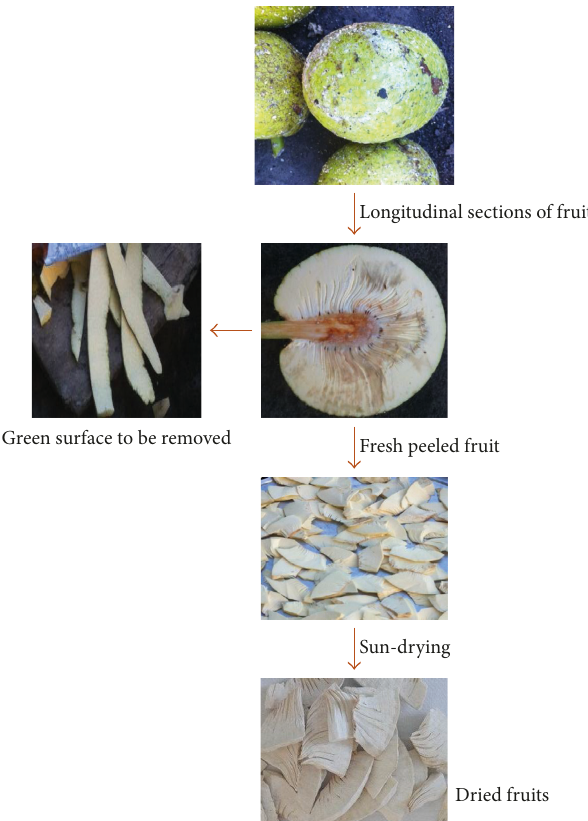
Figure 2: Different stages of breadfruit